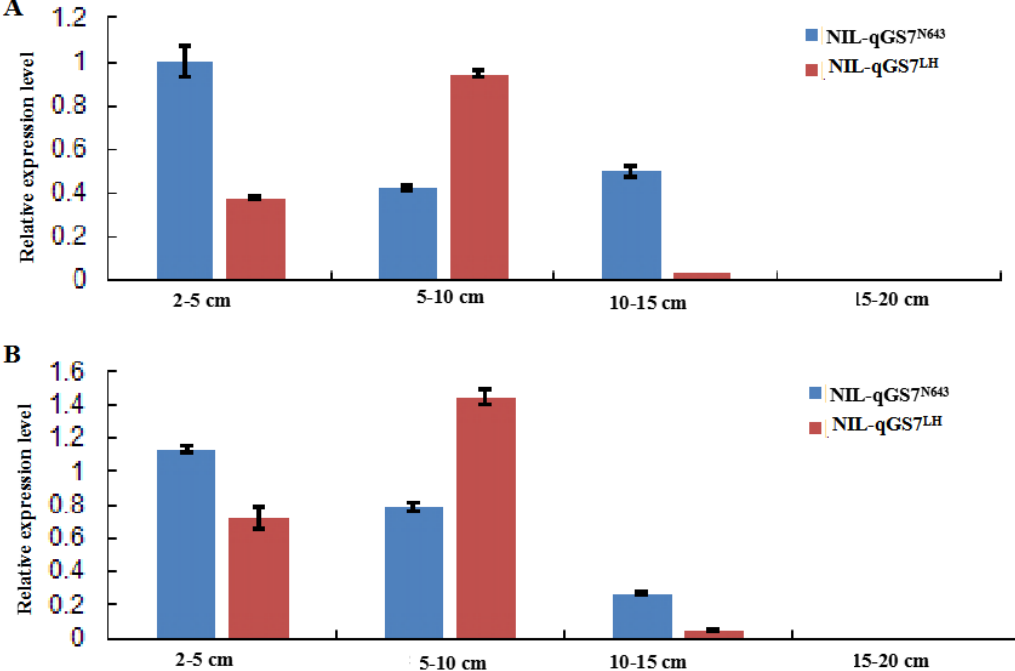
Figure 4. Real-time PCR analysis of candidate genes at four different stage with panicle development. ( A ) The expression level of ORF3 . ( B ) The expression level of ORF7 . Values are the means ± SD of three replicates.